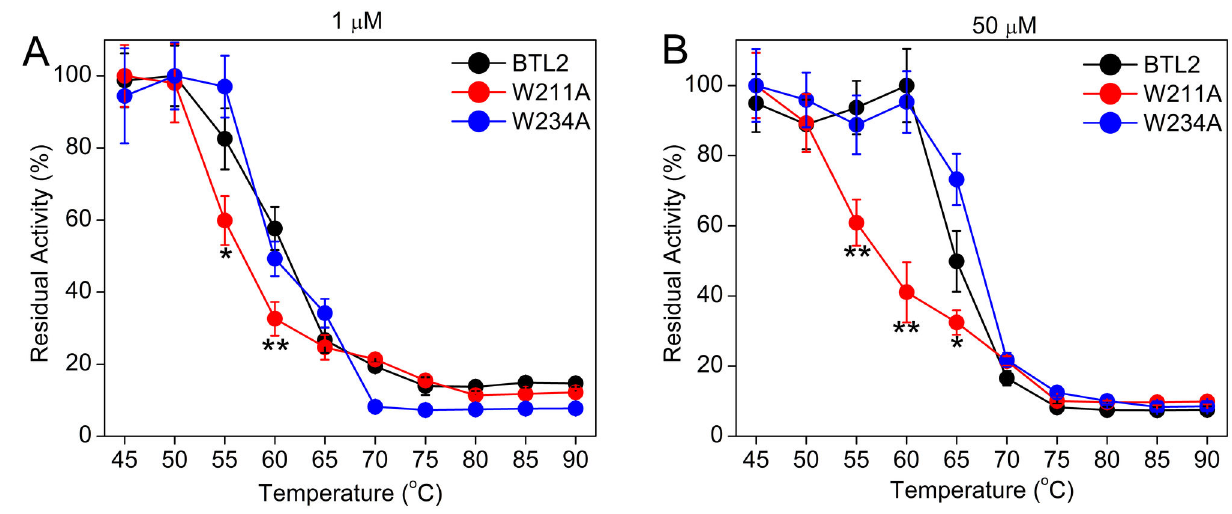
Figure 2. Thermostability at different incubation concentrations. Residual lipase activity after thermal incubation for 30 minutes at concentrations of (A) 1 µM and (B) 50 µM. Student's t-test were performed to determine the significant differences in thermostability of W211A with respect to BTL2 (*p=0.1 and **p=0.05). doi: